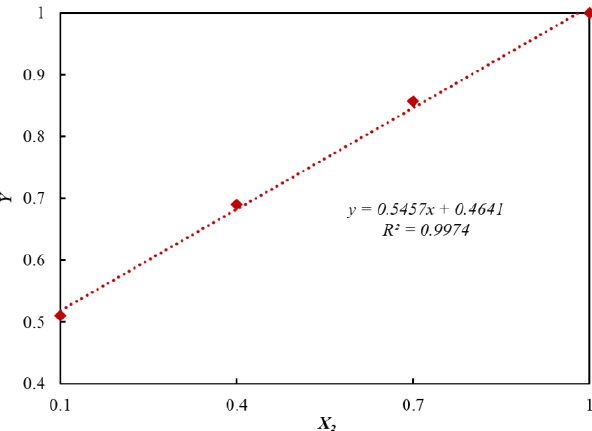
Figure 10. The influence of wellbore initial pressure on downhole perforation peak pressure.